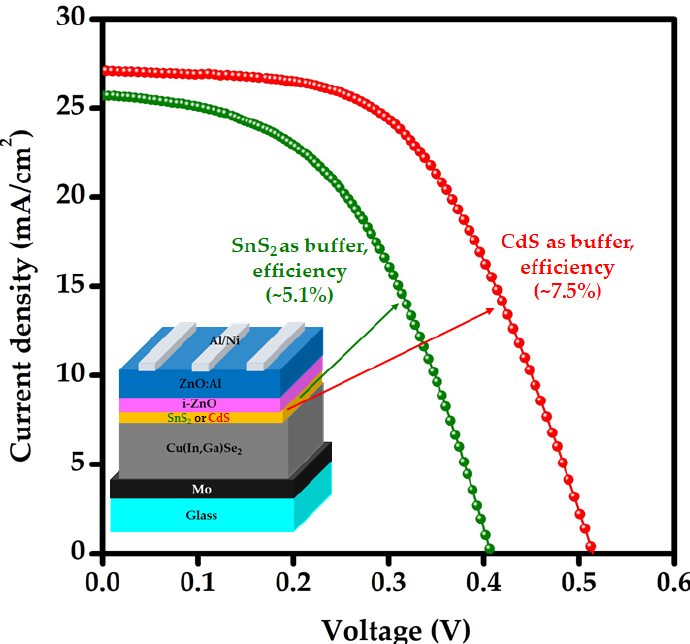
Figure 9. The J–V characteristics of the CIGS devices with conventional CdS and SnS 2 buffer. Table 2. Solar cell performance parameters of CIGS devices with conventional CdS and SnS 2 buffer.